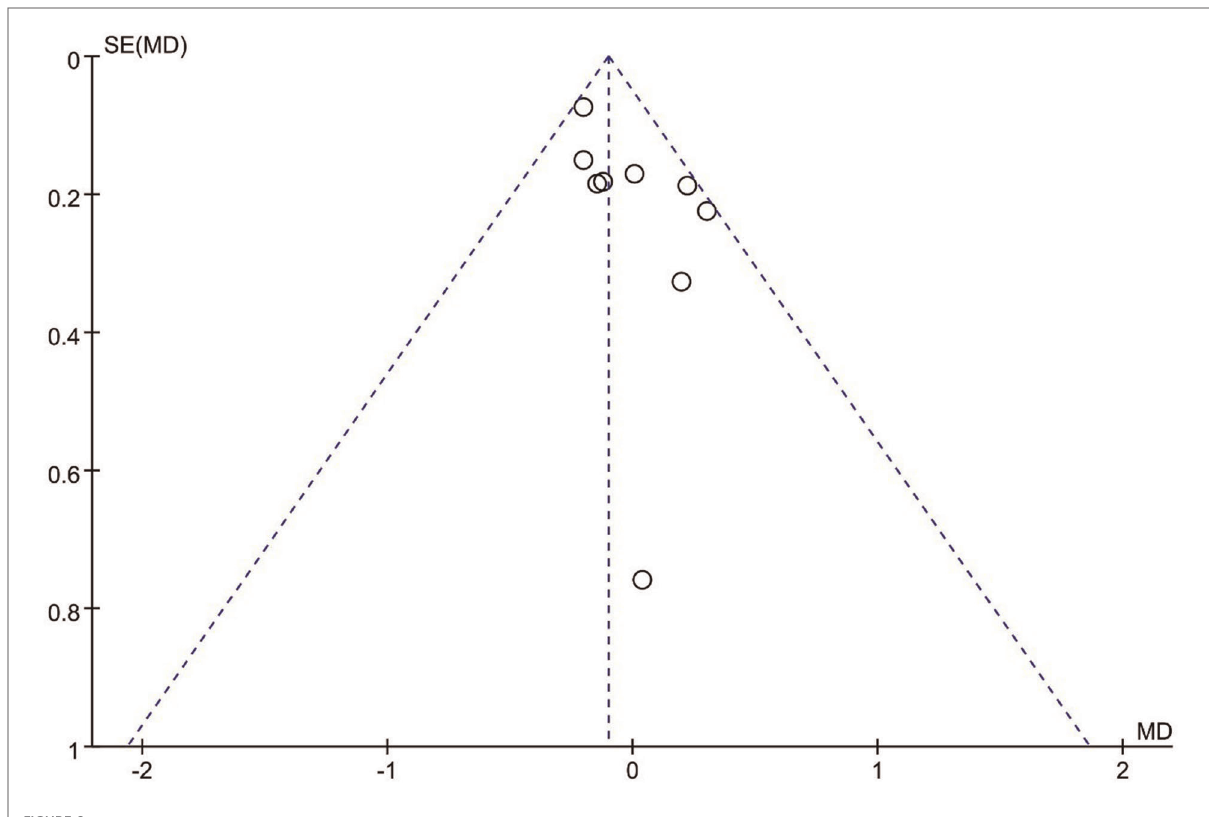
FIGURE 8 Publication bias of long term Vas leg pain UBE vs MED.